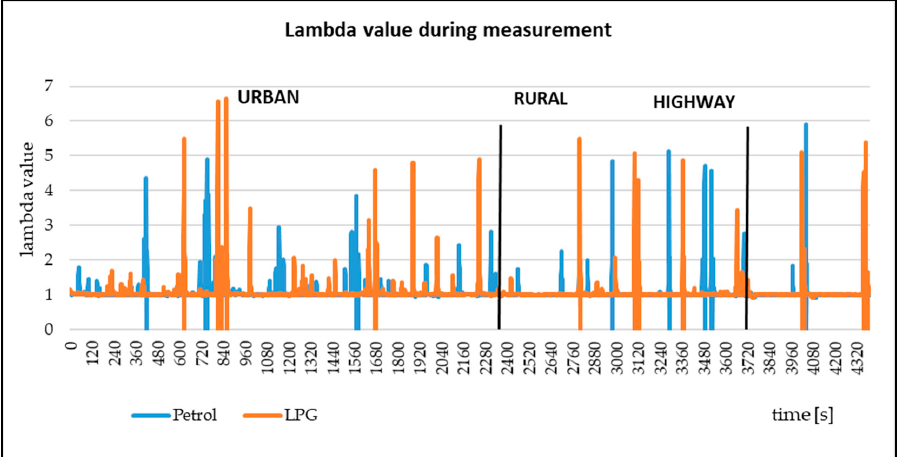
Figure 9. Lambda value during measurement [author] .